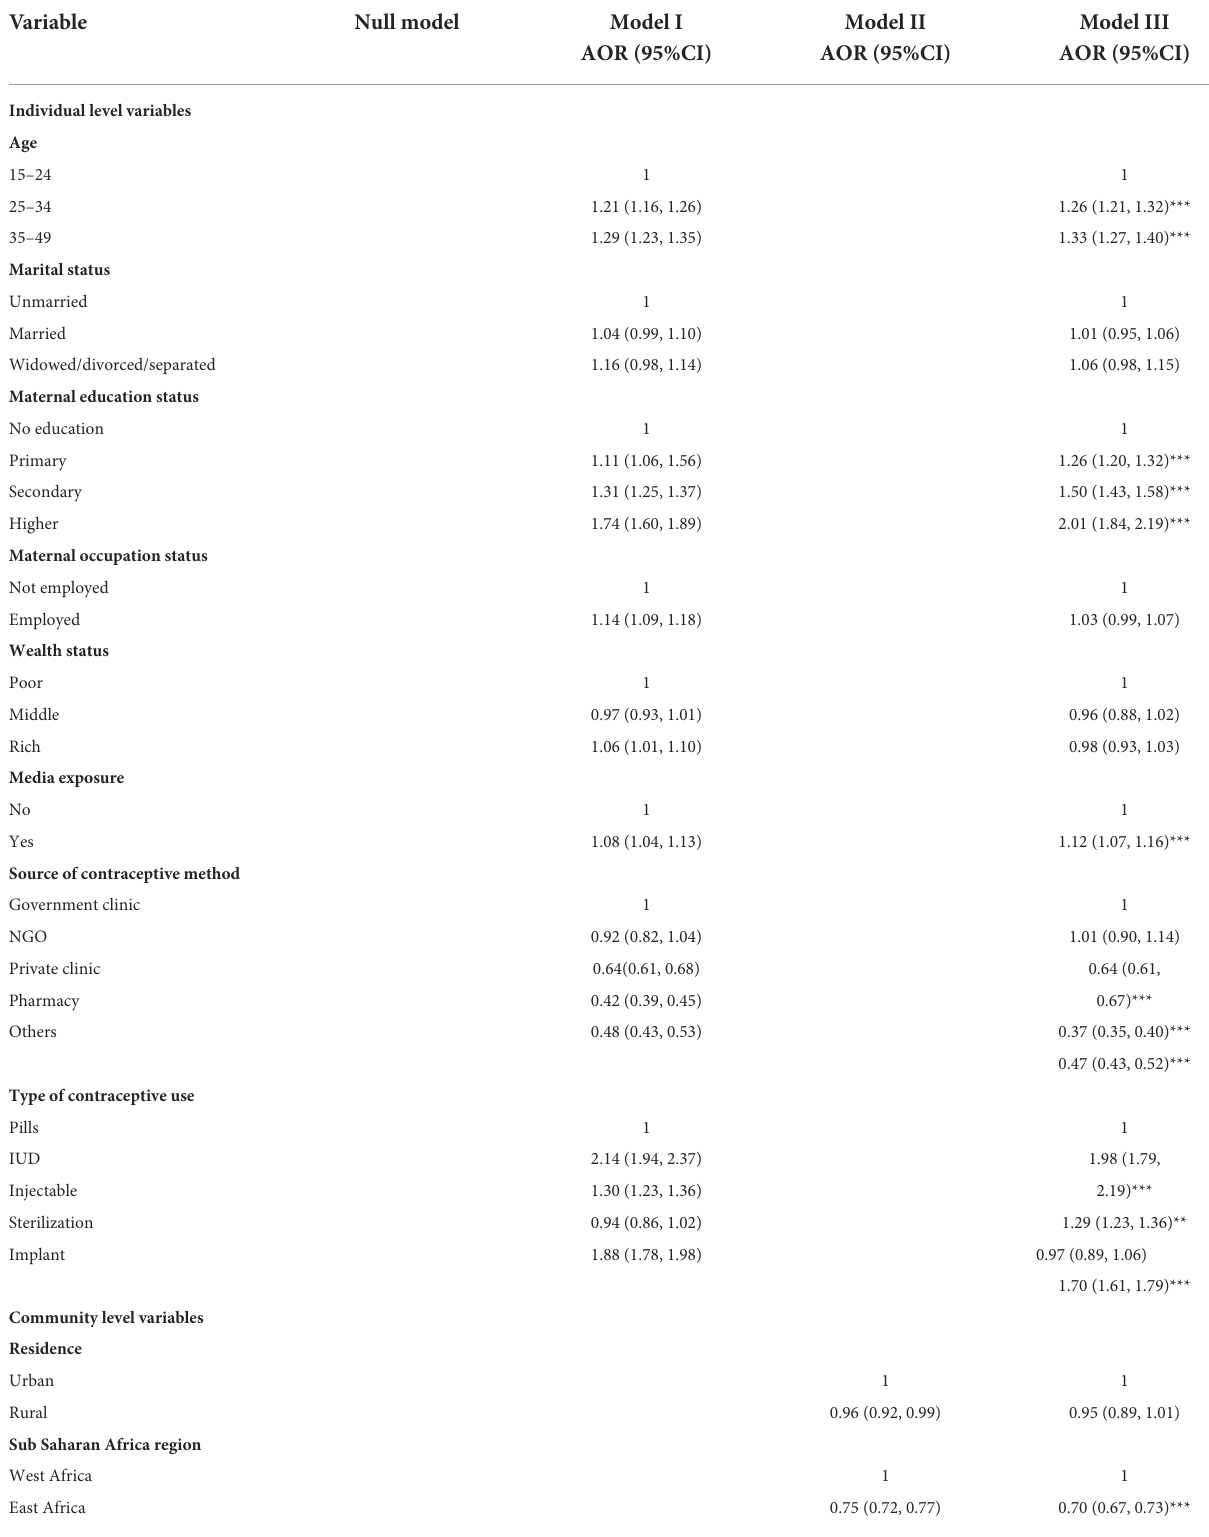
TABLE 4 Individual and community-level determinants of informed choice of contraceptive methods in sub-Saharan Africa.